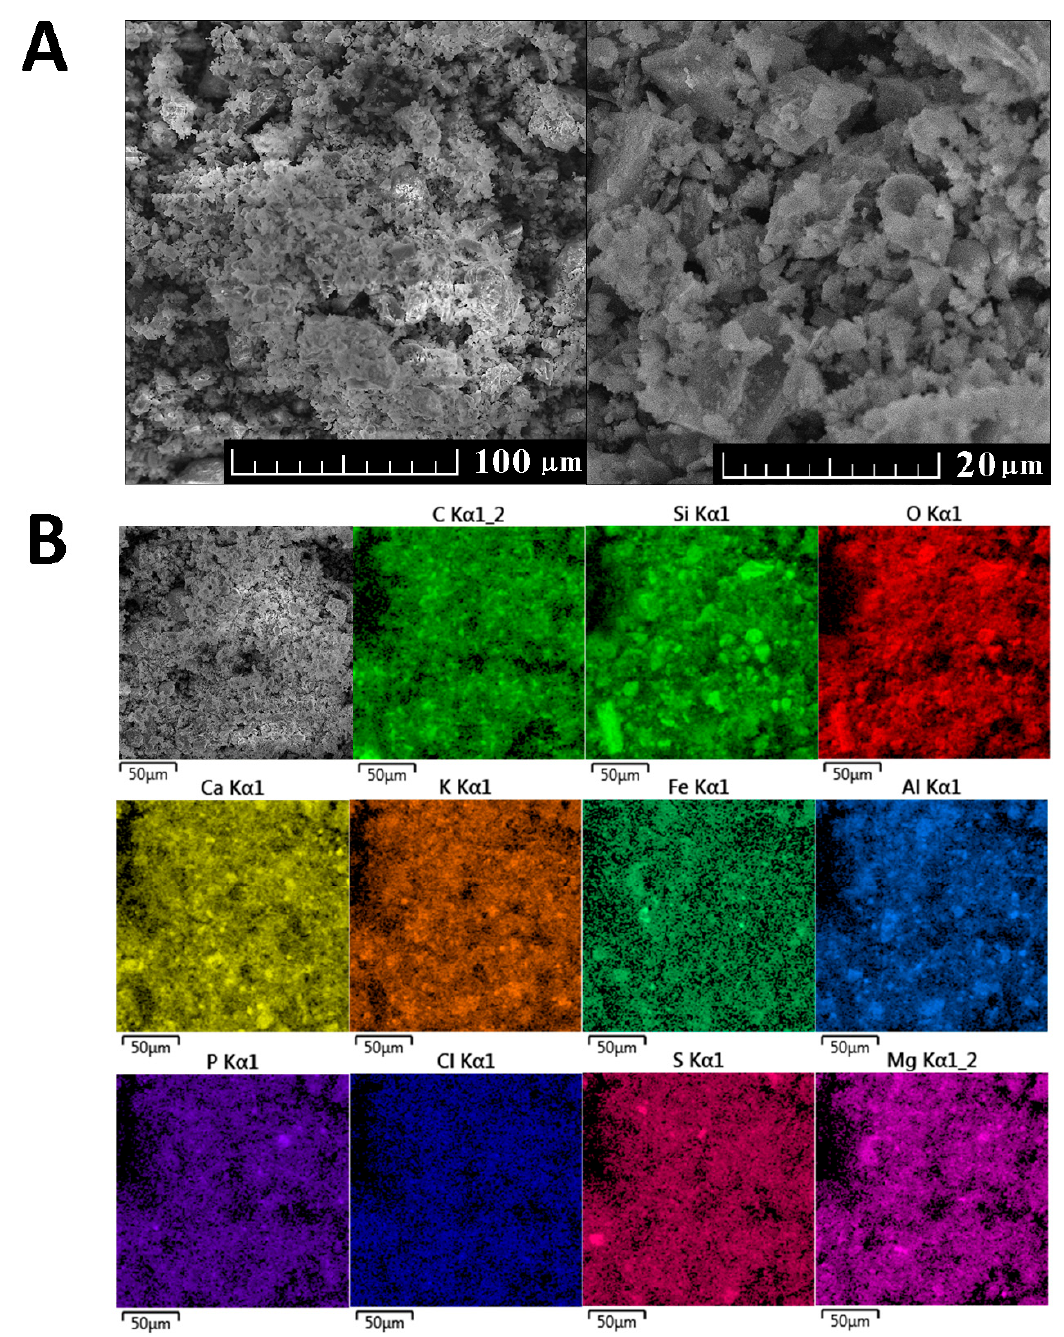
Figure 3. WBA. A) Morphology, B) elemental distribution maps. Figure 3. WBA. ( A ) Morphology, ( B ) elemental distribution